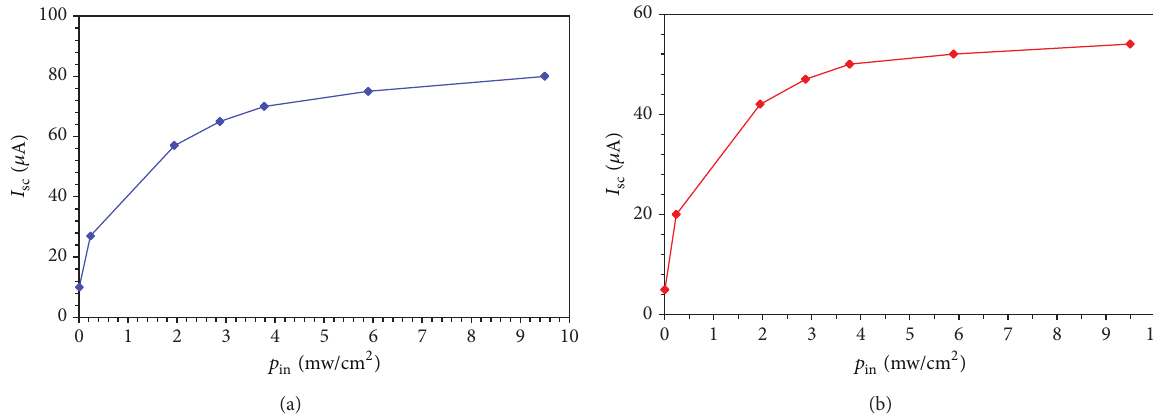
Figure 6: Short-circuit current as a function of the incident photo energy. (a) (n-SnO 2 /SiO 2 /n-Si) device, (b) (n-SnO 2 /SiO 2 /p-Si) device.